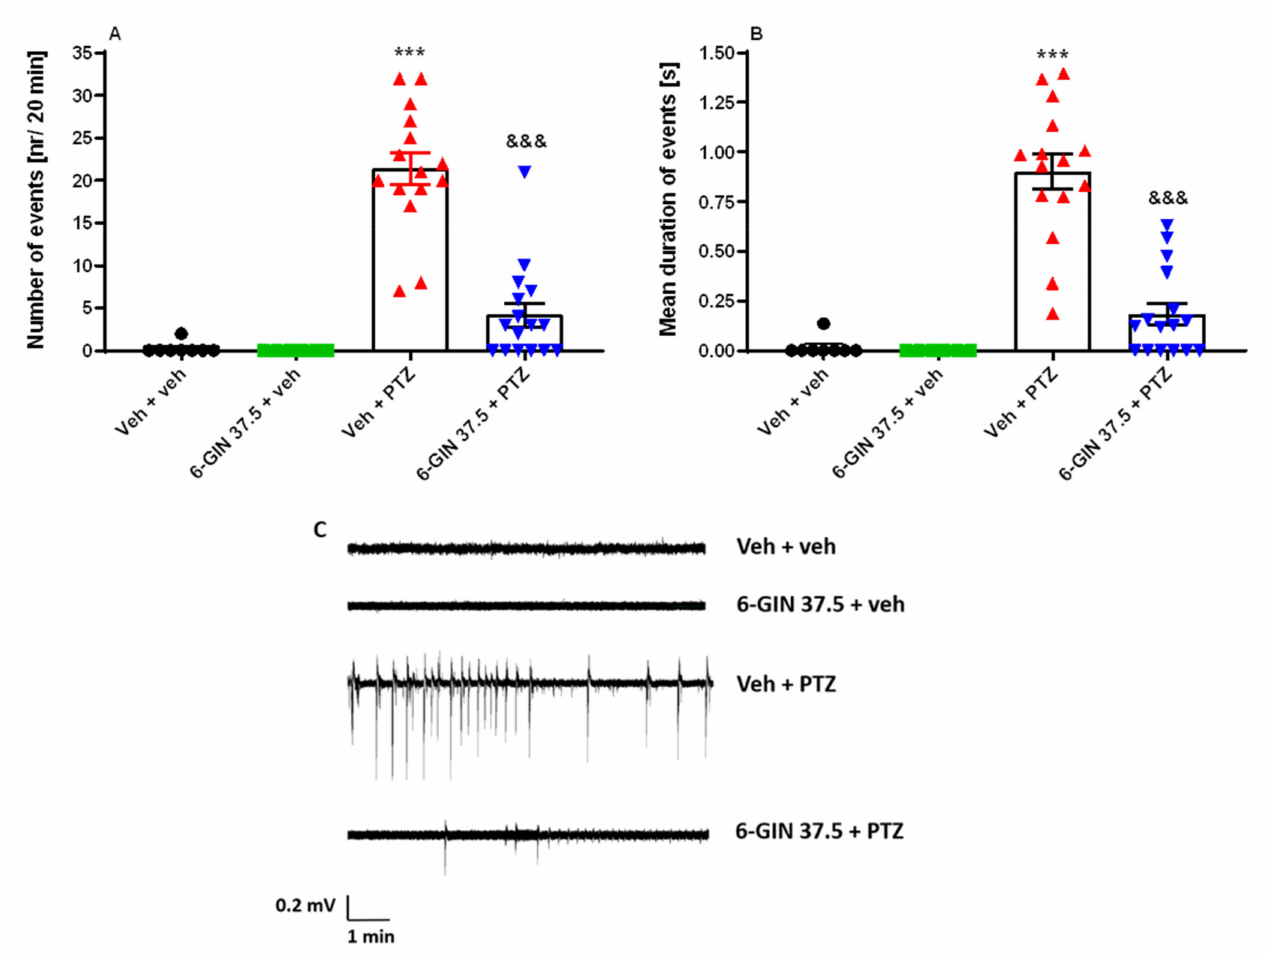
Figure 5. LFP events detected from the optic tectum of 7-day-old zebrafish larvae pre-exposed for 24 h to 6-GIN (37.5 µ M). Subsequently, each larva was incubated with 20 mM PTZ or Veh for 5 min, before being mounted in agarose for LFP recordings. Data are shown as: ( A ) the number of events (nr/20 min), and ( B ) the mean duration of events (s/20 min). Data were analyzed using one-way ANOVA followed by Tukey’s post hoc test. Data are depicted as mean ± SEM. Veh + veh ( n = 8), 6-GIN 37.5 + Veh ( n = 6), Veh + PTZ ( n = 14), 6-GIN 37.5 + PTZ ( n = 16). *** p < 0.001 vs. Veh + veh; &&& p < 0.001 vs. Veh + PTZ. ( C ) Representative traces of recordings. 6-GIN—6-gingerol, PTZ—pentylenetetrazole, Veh—vehicle. n —refers to the total number of